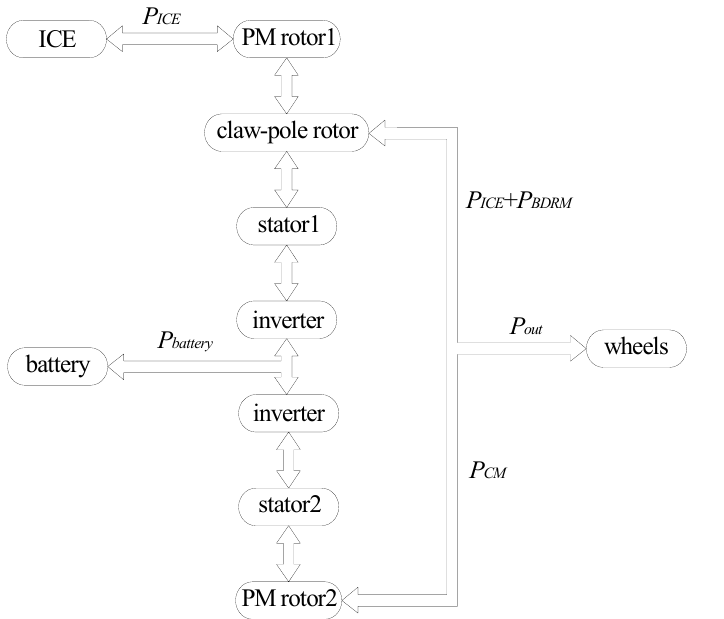
Figure 3. Power flow path in the brushless CS-PMSM